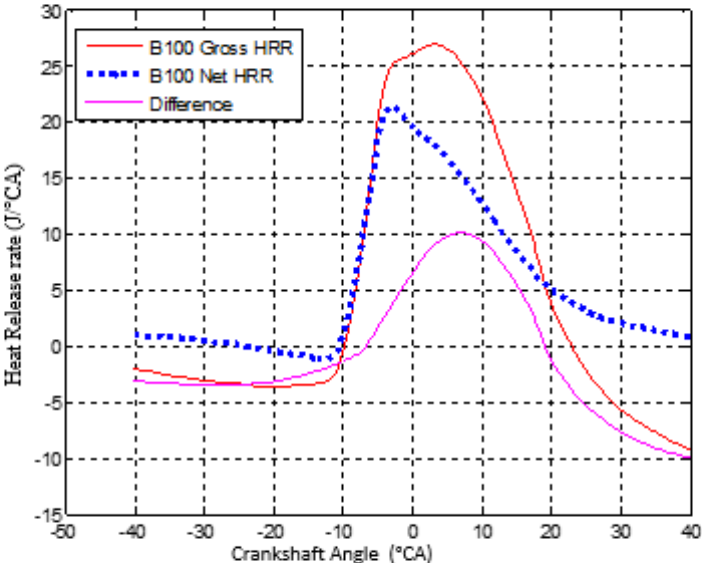
Figure 11. Profile of net heat release rate (Net HRR) evolution and gross heat release rate (Gross HRR) for engine speed n = 1500 rpm at 75% load according to the B100 combustion analysis model.